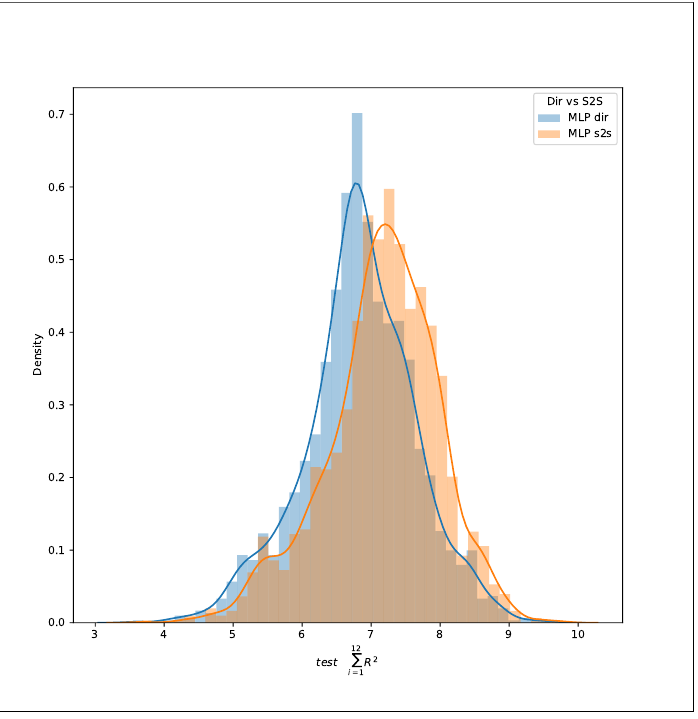
Figure 4. Probability distribution function comparison between MLP’s direct regression distribution and MLP (MLP seq2seq shows marginally better